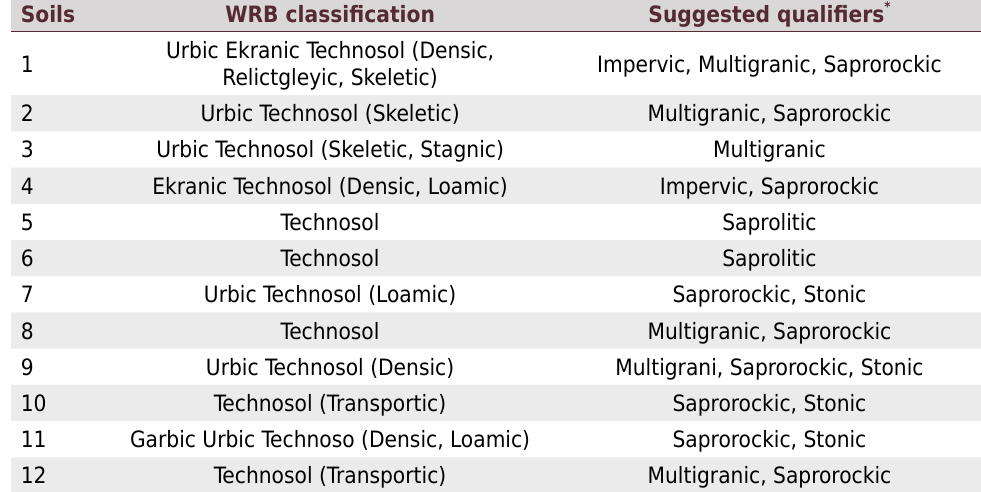
Qualifiers suggested from the data of the 12 profiles evaluated in this